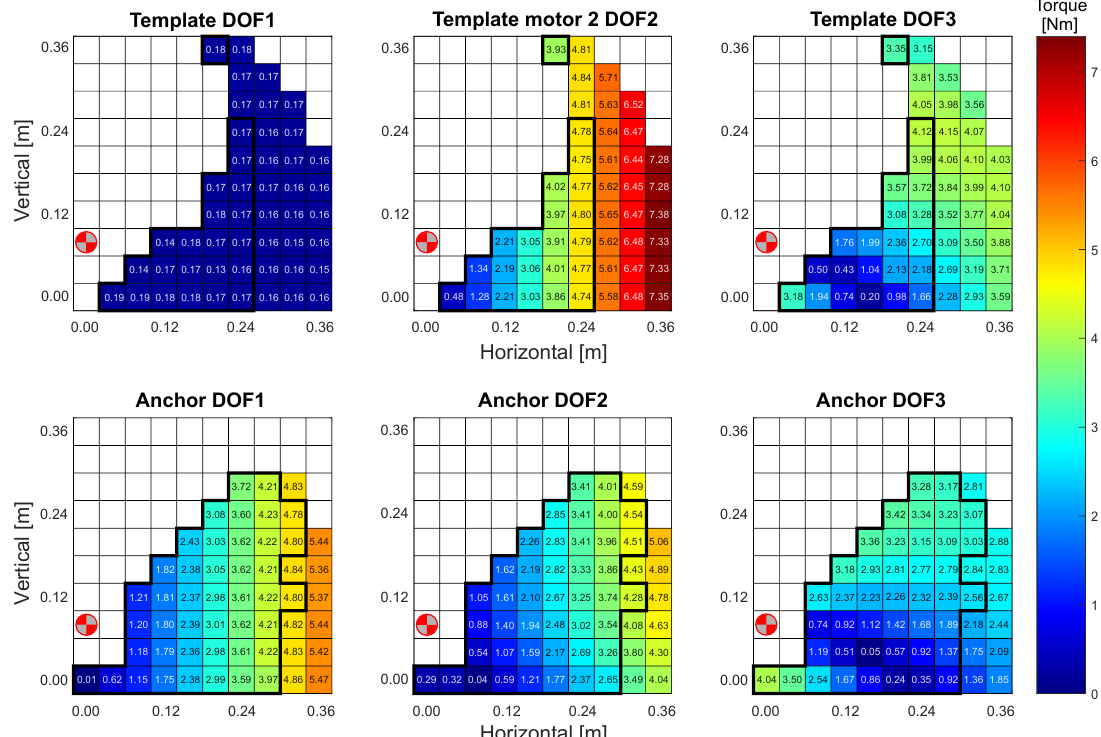
Figure 12. Both the template morphology’s ( top ) and the anchor morphology’s ( bottom ) ability to step onto obstacles or objects of varying distance and heights from the origin point (red dots 0.08 m above ground) while being loaded with 2.0 kg. A thick line encloses the areas where the morphologies were able to reach without any of their three motors were overloaded (4.8 Nm) for each specific